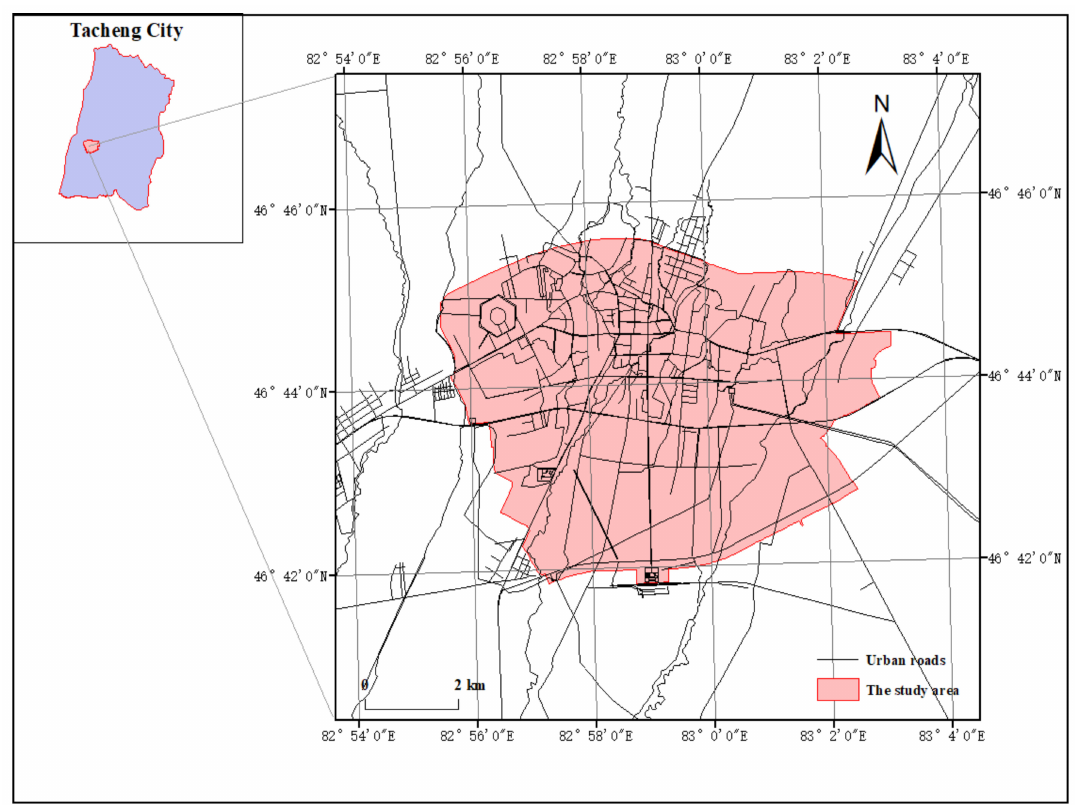
Figure 1. Geographical scope of the research.